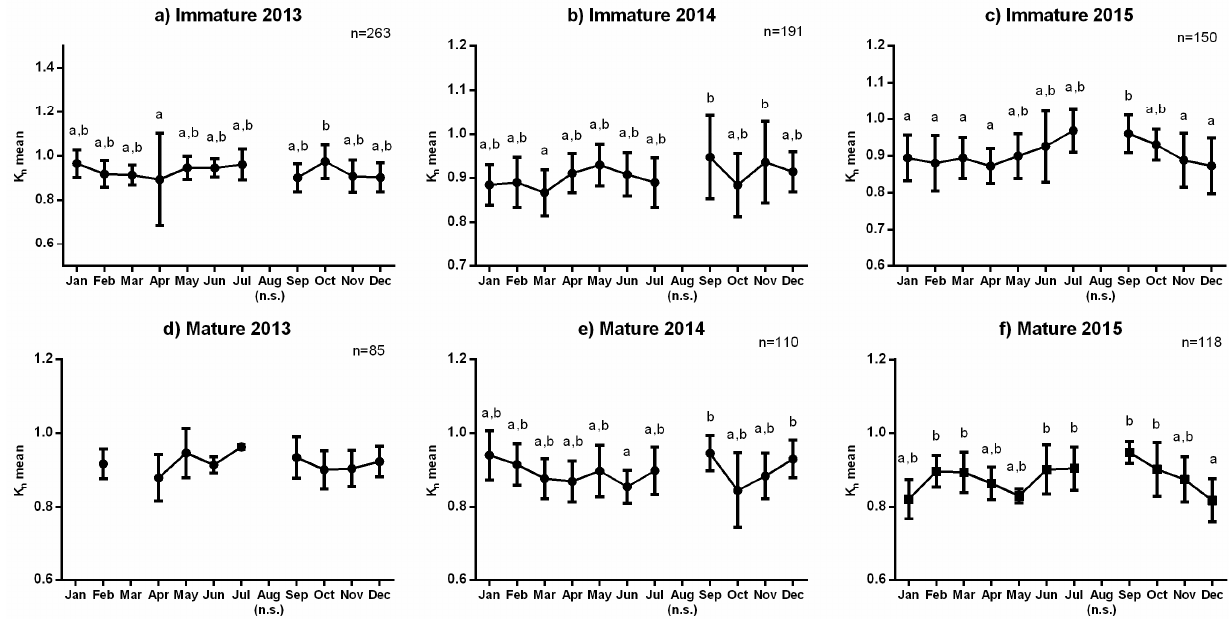
Figure 4. Monthly variation of European hake female Le Cren’s condition factor ( K n ) for three years in different ovarian stages. Graphics ( a – c ) indicate the females in the immature phase; graphics ( d – f ) show females from developing to regenerating phase. In January and March of 2013, mature individuals were not found. In August of the three years, no samples (n.s.) were sampled. The letters indicate a statistically significant difference among groups ( p < 0.05) determined by Tukey’s multiple comparison test.